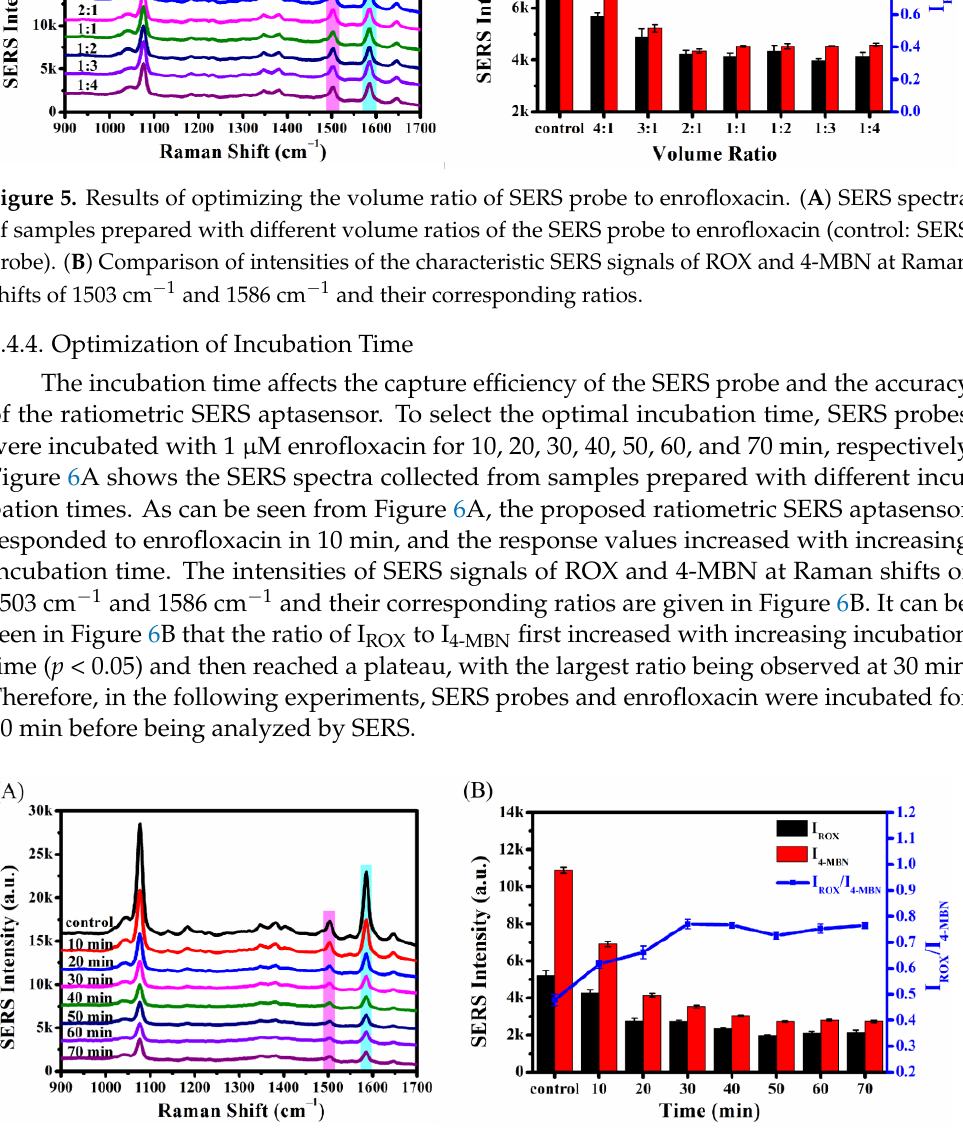
Figure 6. Results of optimizing the incubation time of SERS probes and enrofloxacin. ( A ) SERS spectra of samples prepared by incubating SERS probes and enrofloxacin for 10–70 min (control: SERS probe). ( B ) Intensities of SERS signals of ROX and 4-MBN at Raman shifts of 1503 cm −1 and 1586 cm −1 and their corresponding ratios.